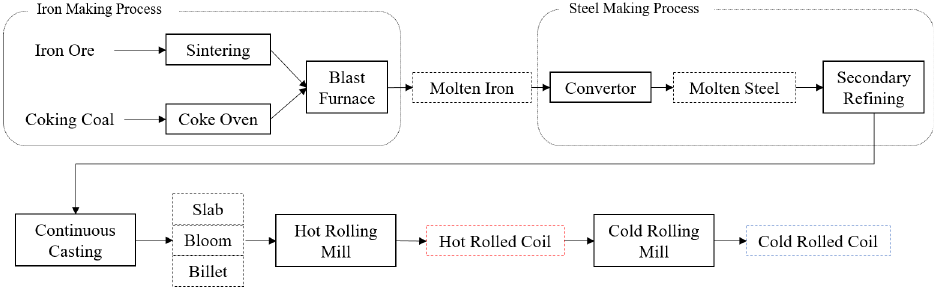
Figure 1. Overview of the steel manufacturing